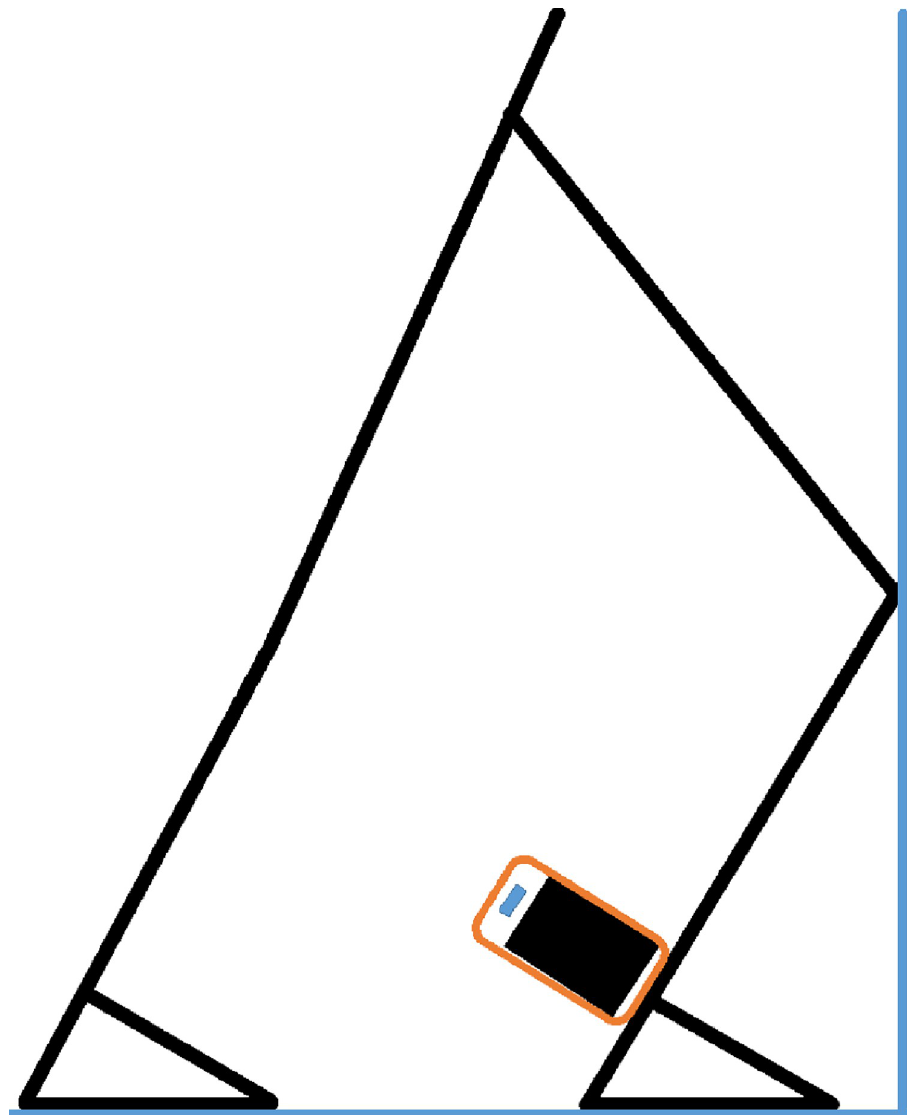
Fig 1. Position of weight-bearing lunge test (WBLT) demonstrated with Cell-Phone positioning. After data collection, the landing technique was evaluated using Kinovea software (version 0.8.15, Kinovea Open Source Project, www.kinovea.org) and video scoring was based on the items in Table 1, which was adapted from the landing error scoring system (LESS), originally developed by Padua et al [25]. LESS assesses 17 items on a scale from 0–19. A higher score (greater number of landing errors) indicates potentially high-risk movement patterns [25]. The landing of all participants was quantified by a trained LESS rater (H.A.). The movements of the lower extremities and trunk were analyzed at the moment of "initial contact of the foot with the ground" and "between initial contact of the foot with the ground and maximum knee flexion" and only for the right foot to simplify the evaluation. To analyze the overall landing technique, the mean of the scores from the 3 jump landing trials was calculated.